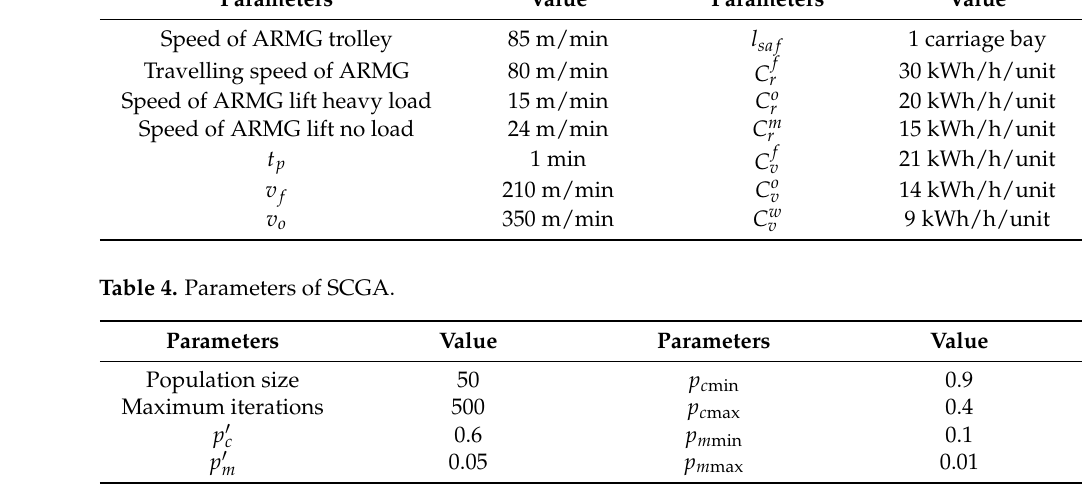
Table 5. Comparison of different scheduling